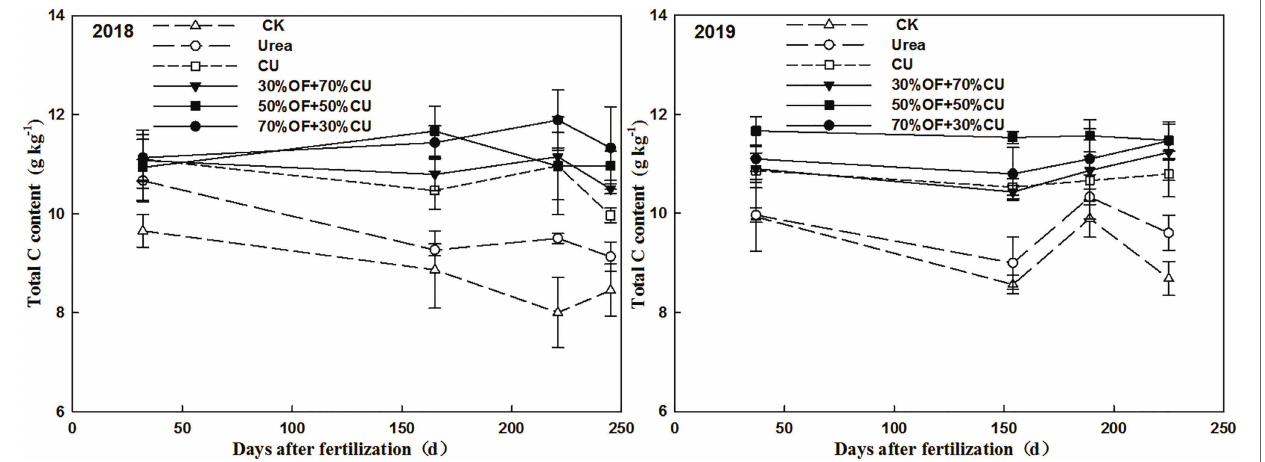
FIGURE 6 | Variations in the total carbon concentrations of the 0–20-cm